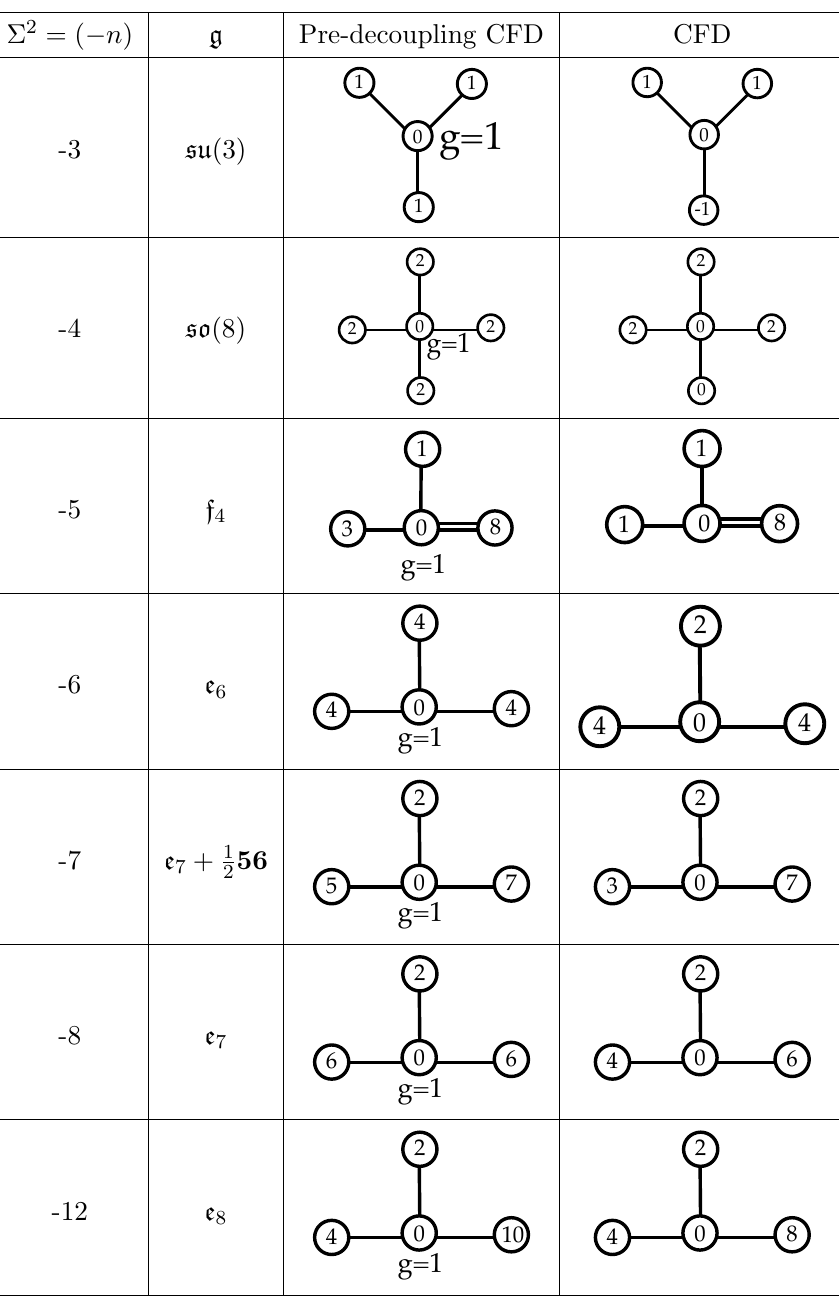
Table 4. CFDs for NHCs: the (cid:12)rst column denotes the self-intersection number of the rational curve in the base of the elliptic (cid:12)bration, g is the non-Higgsable gauge group. The last two columns show the CFDs before and after the decoupling of the gauge